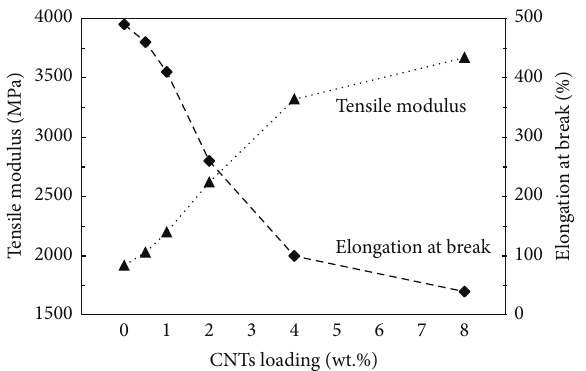
Figure 7: Tensile modulus and elongation at break of nanocompos- ites determined from static stress-strain testing data.